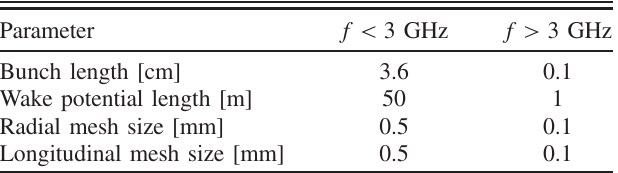
TABLE II. Parameters used in ABCI simulations with results shown in Fig.